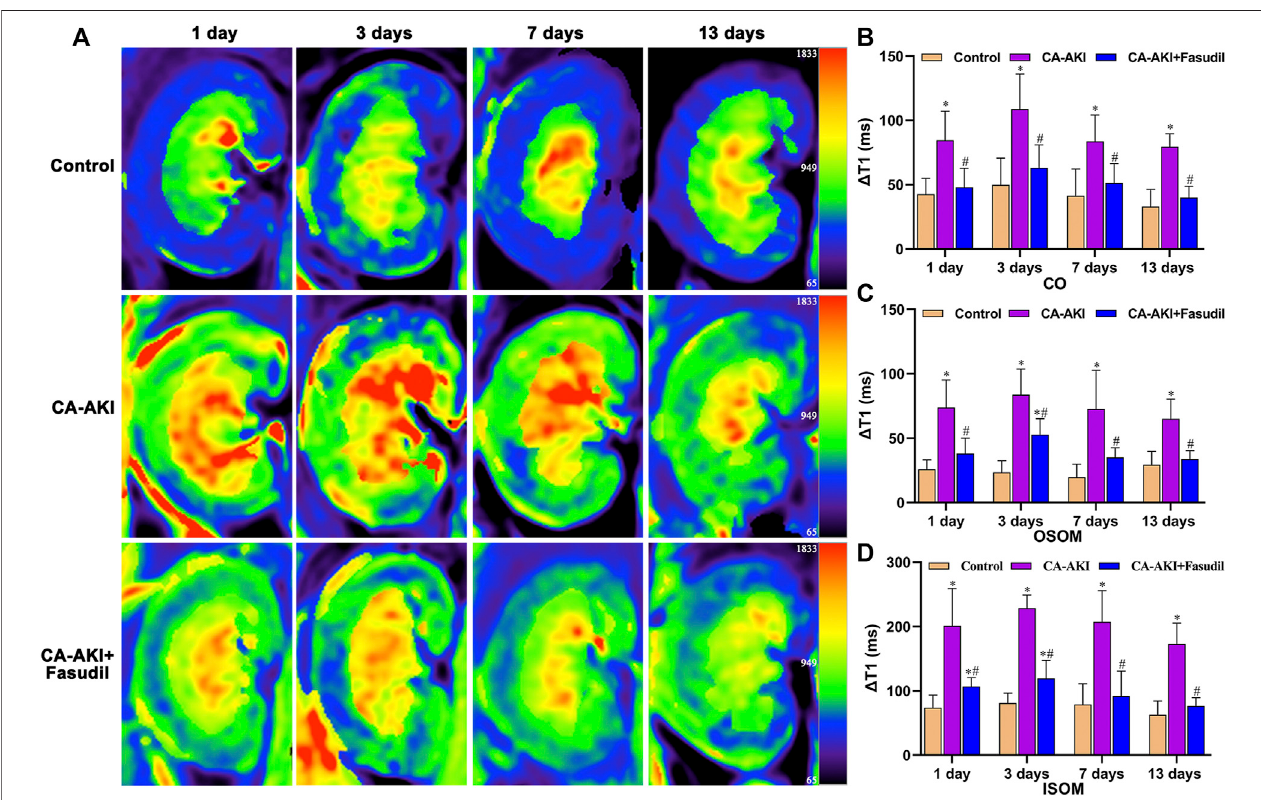
FIGURE 4 | Representative T1 mapping outcomes in three animal groups: (A) Parametric images obtained by T1 mapping and (B – D) quantitative analysis of Δ T1 values at CO, OSOM, and ISOM.* p < 0.05 between CA-AKI/CA-AKI + Fasudil and controls; # p < 0.05 between CA-AKI + Fasudil and CA-AKI. CA-AKI: contrast- associated acute kidney injury; ISOM: inner stripe of the outer medulla; CO: cortex; OSOM: outer stripe of the outer medulla.